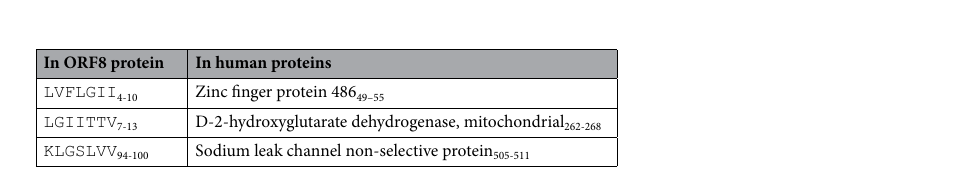
Table 9. Localization of homologous 7-mers in the ORF8 protein and human proteins.